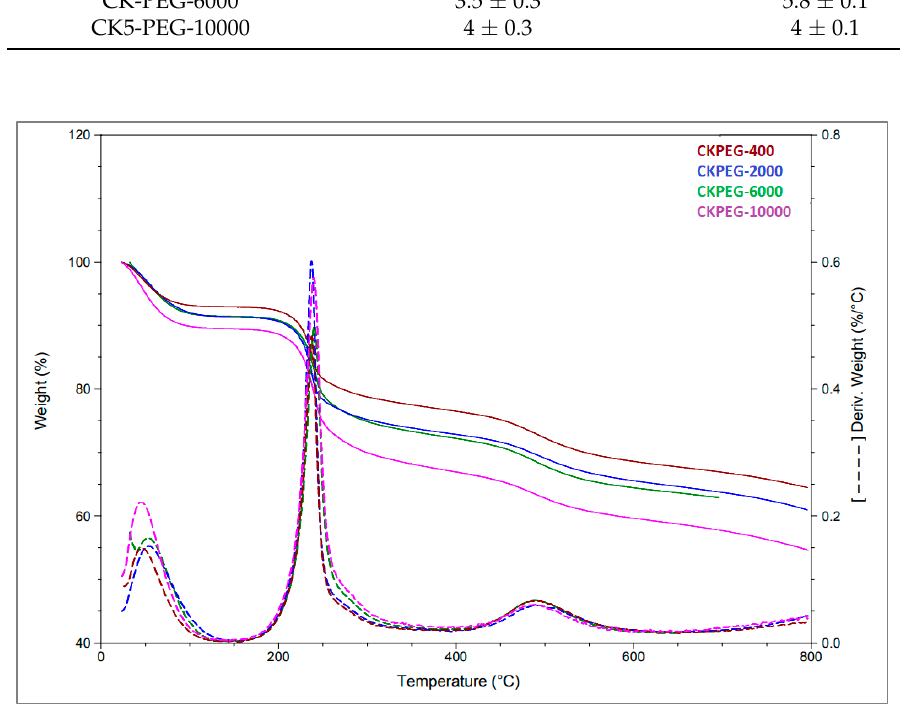
Figure 10. TG and DTG curves of composite membranes using varying PEG Mw.